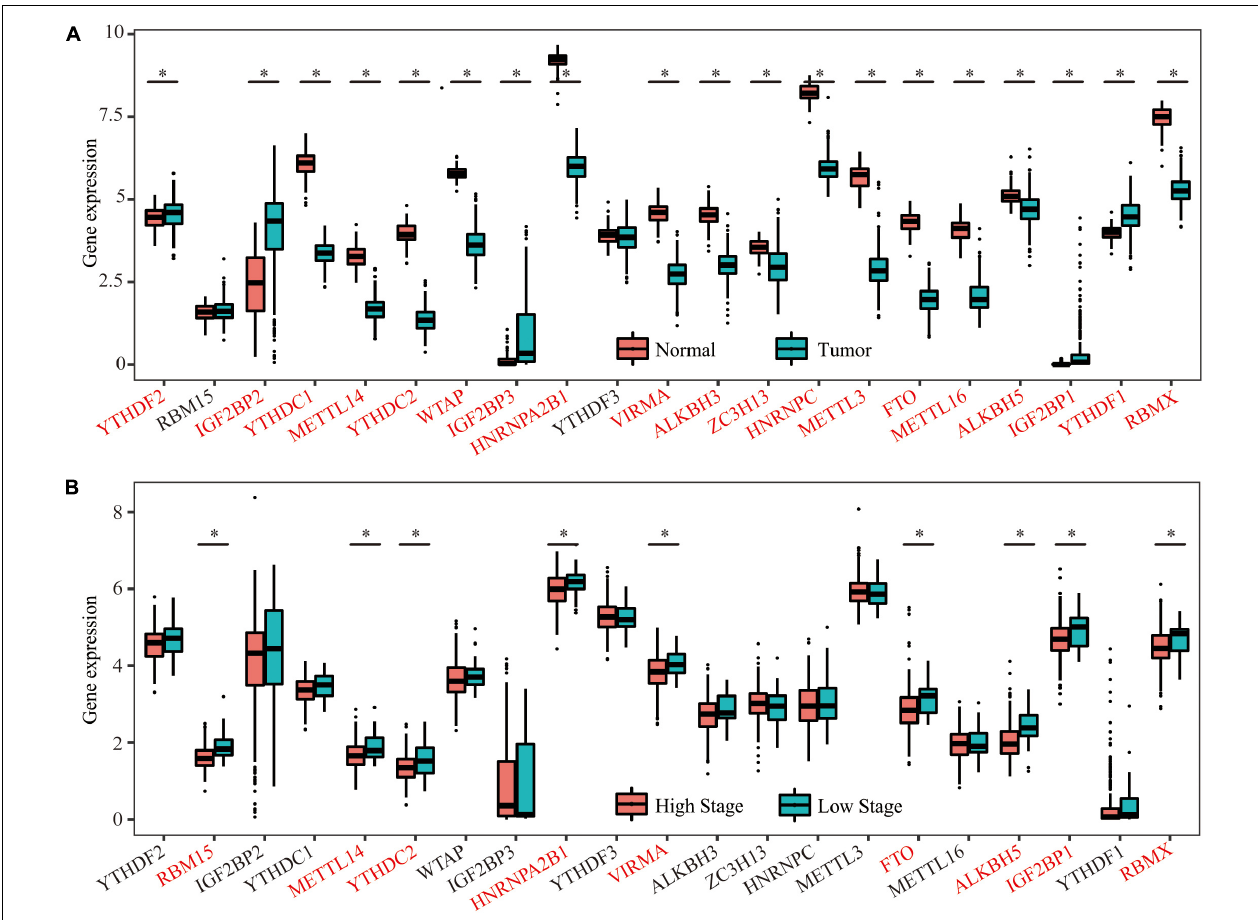
FIGURE 2 | Expression of 21 m6A RNA methylation regulators in OC tissues and normal human ovarian tissues. (A) Five m6A regulators (YTHDF1, YTHDF2, IGF2BP1, IGF2BP2, and IGF2BP3) were upregulated, and 14 m6A regulators (METTL3, METTL14, METTL16, ZC3H13, WTAP, VIRMA, RBMX, YTHDC1, YTHDC2, HNRNPC, HNRNPA2B1, FTO, ALKBH3, and ALKBH5) were downregulated in the OC tissues compared with the control tissues. (B) Nine of the 21 m6A regulators (METTL14, YTHDC2, FTO, ALKBH5, HNRNPA2B1, VIRMA, IGF2BP1, RBM15, and RBMX) were significantly differentially expressed in the two groups, and all of them were downregulated in the high-stage group compared with the low-stage group * P <